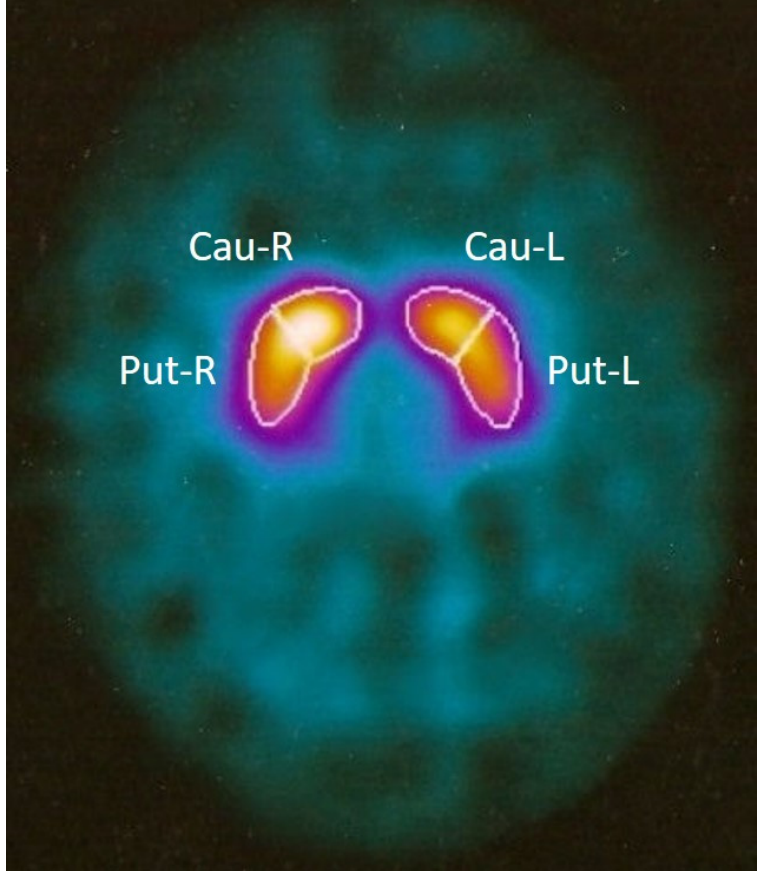
Figure 1. DaTScan assessment. No abnormalities of the nigro-striatal pathway were found bilaterally. Cau-R/L, Caudatum Right/Left; Put-R/L, Putamen Right/Left. Levodopa 500 mg/day and Amantadine 200 mg/day were started. Sodium Valproate, which can cause parkinsonism [13], was replaced with Topiramate. After hospital